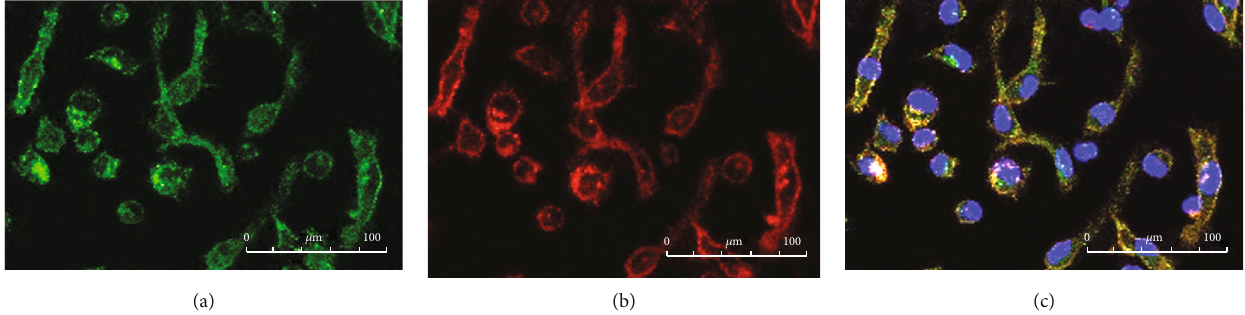
Figure 3: Immuno fl uorescence of TLR4 and CD14 in the ANA- group after LPS stimulation. (a) Monocytes were identi fi ed by CD14. Some cells changed from round to fusiform. (b) TLR4 was mainly expressed in the cell membrane. (c) Under LPS stimulation, mononuclear cells coexpressed TLR4 and